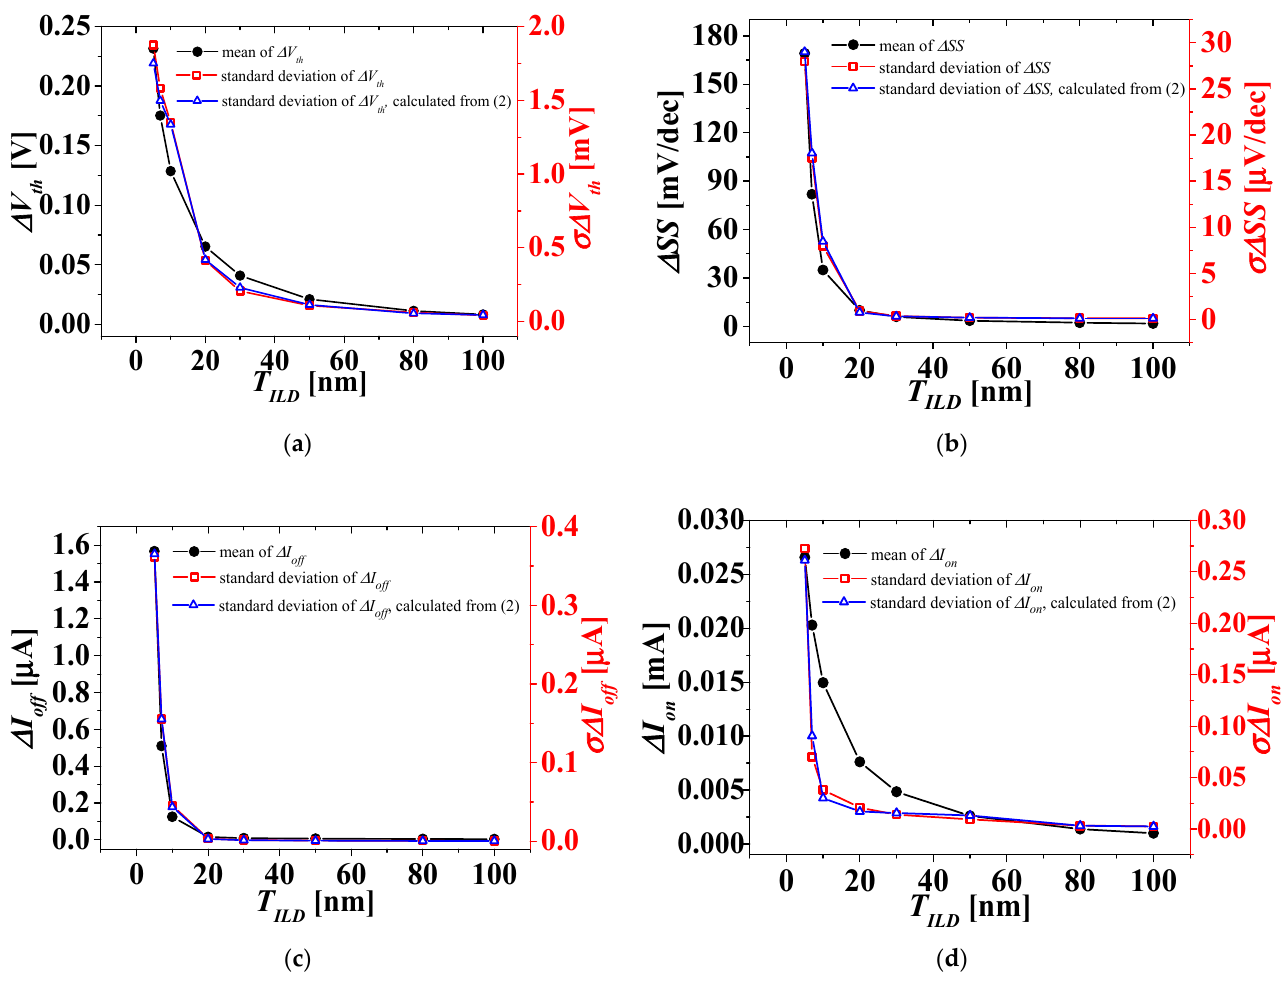
Figure 10. Means (left axis) and standard deviations (right axis) considering both WFVs on the TiN gate of top-tier NMOS and the MoN gate of bottom-tier PMOS. ( a ) Δ V th , ( b ) Δ SS, ( c ) Δ I off , and ( d ) Δ I on .